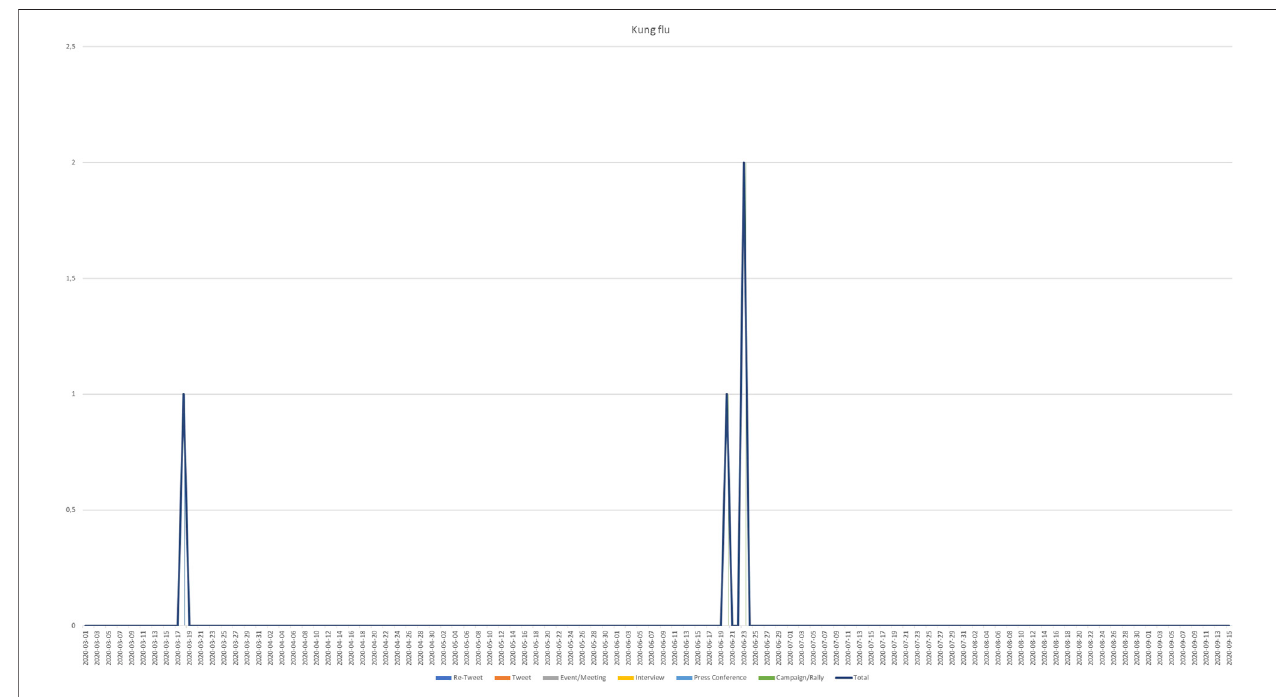
FIGURE 4 | Kung fl